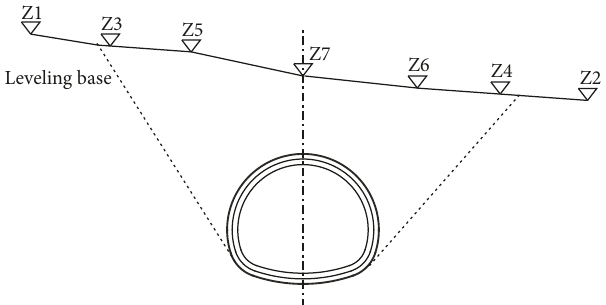
Figure 10: The measuring point of entrance and shallow buried